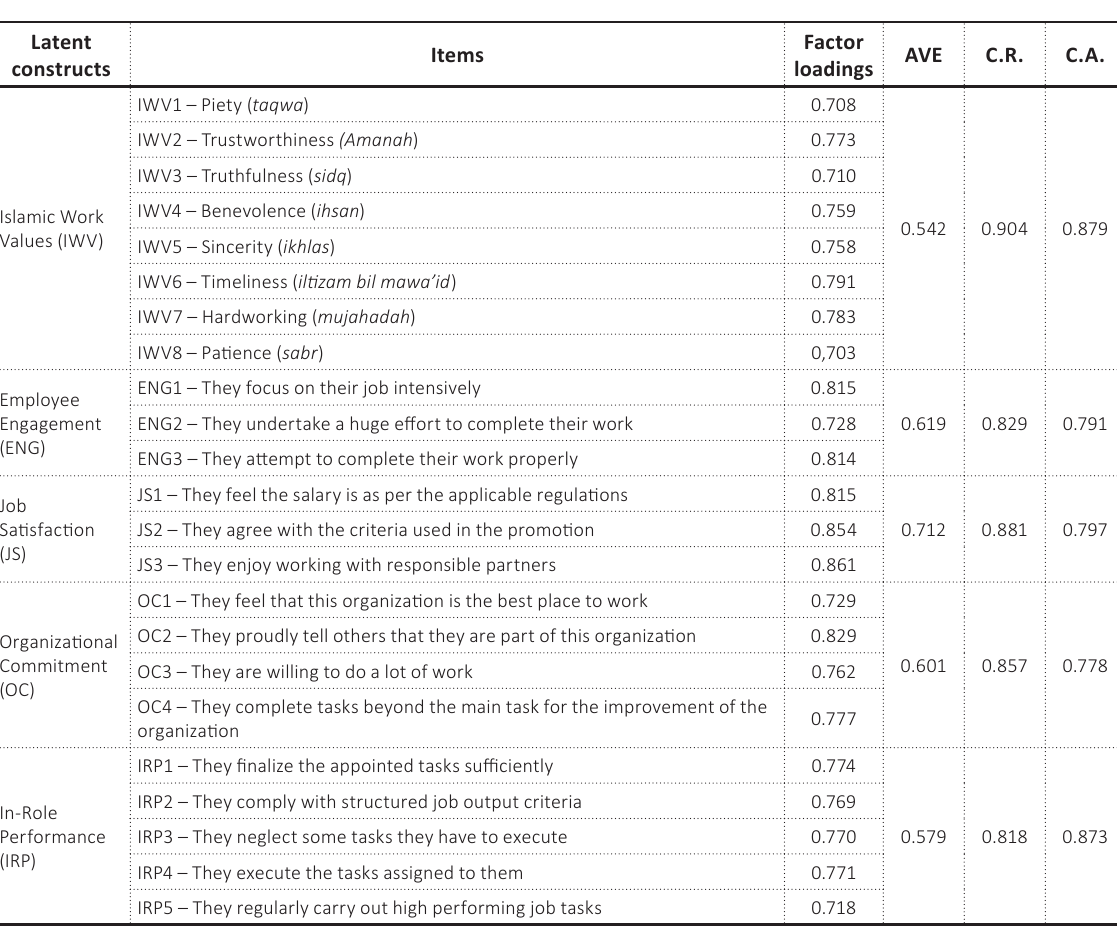
Table 2. Outer model